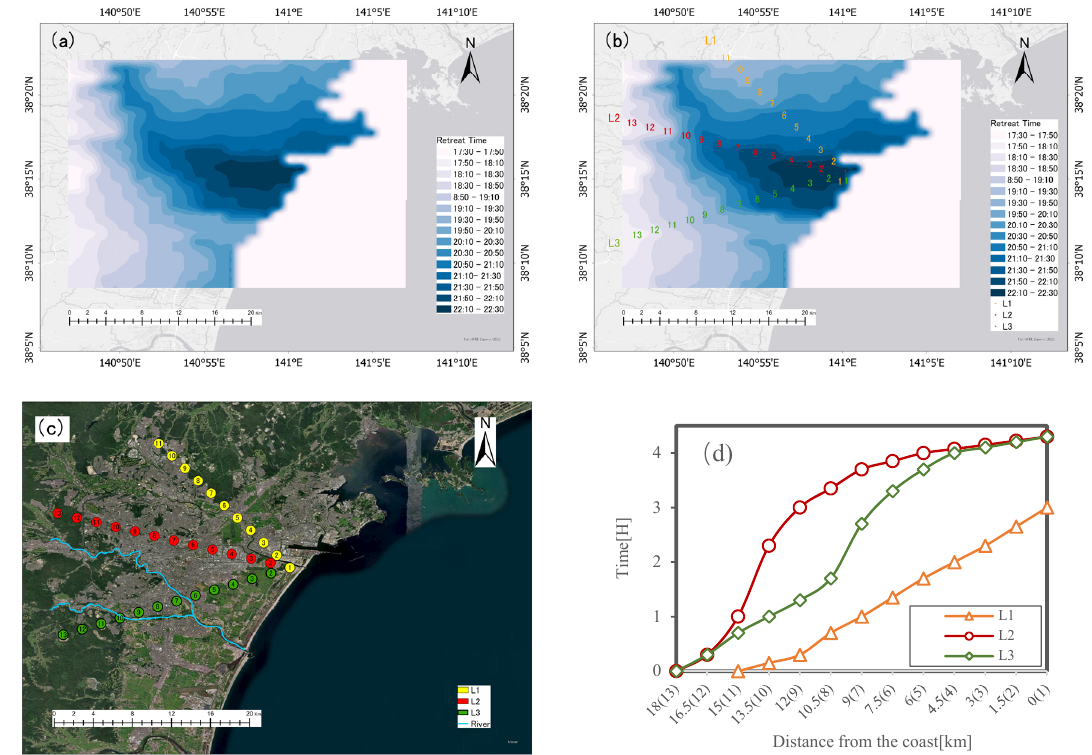
Figure 12. ( a ) Sea breeze retreat time map; ( b ) distribution of points in the L1, L2 and L3 directions on the sea breeze retreat time map; ( c ) distribution of points in the L1, L2 and L3 directions on the satellite map; ( d ) the time when the L1, L2, and L3 directions retreat to each point.